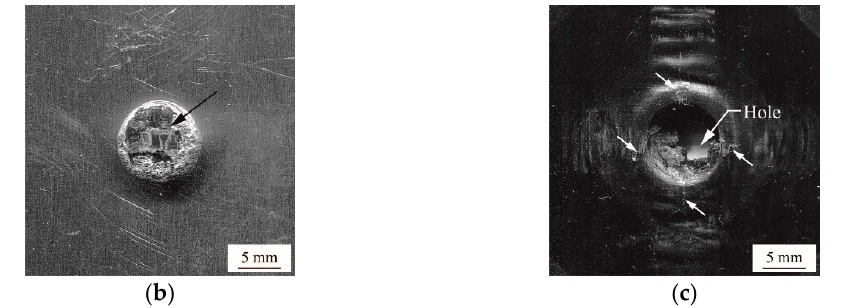
Figure 14. ( a ) A cross-sectional micrograph of a failed clinch joint subjected to quasi-static cross-tension loads. ( b ) The bottom surface of the upper sheet (AA5052) and ( c ) the top surface of the lower sheet (TP-CFRP) with a failed clinch joint.